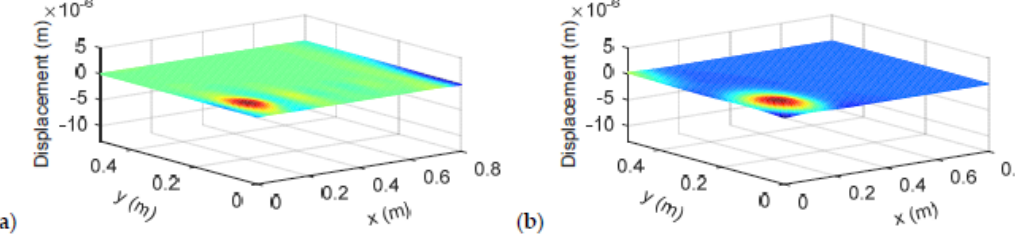
Figure 8. Displacement profiles of the finite locally resonant plate with fully free boundary conditions at ( a ) 202 Hz within the 1st band gap and ( b ) 310 Hz within the 2nd band gap.